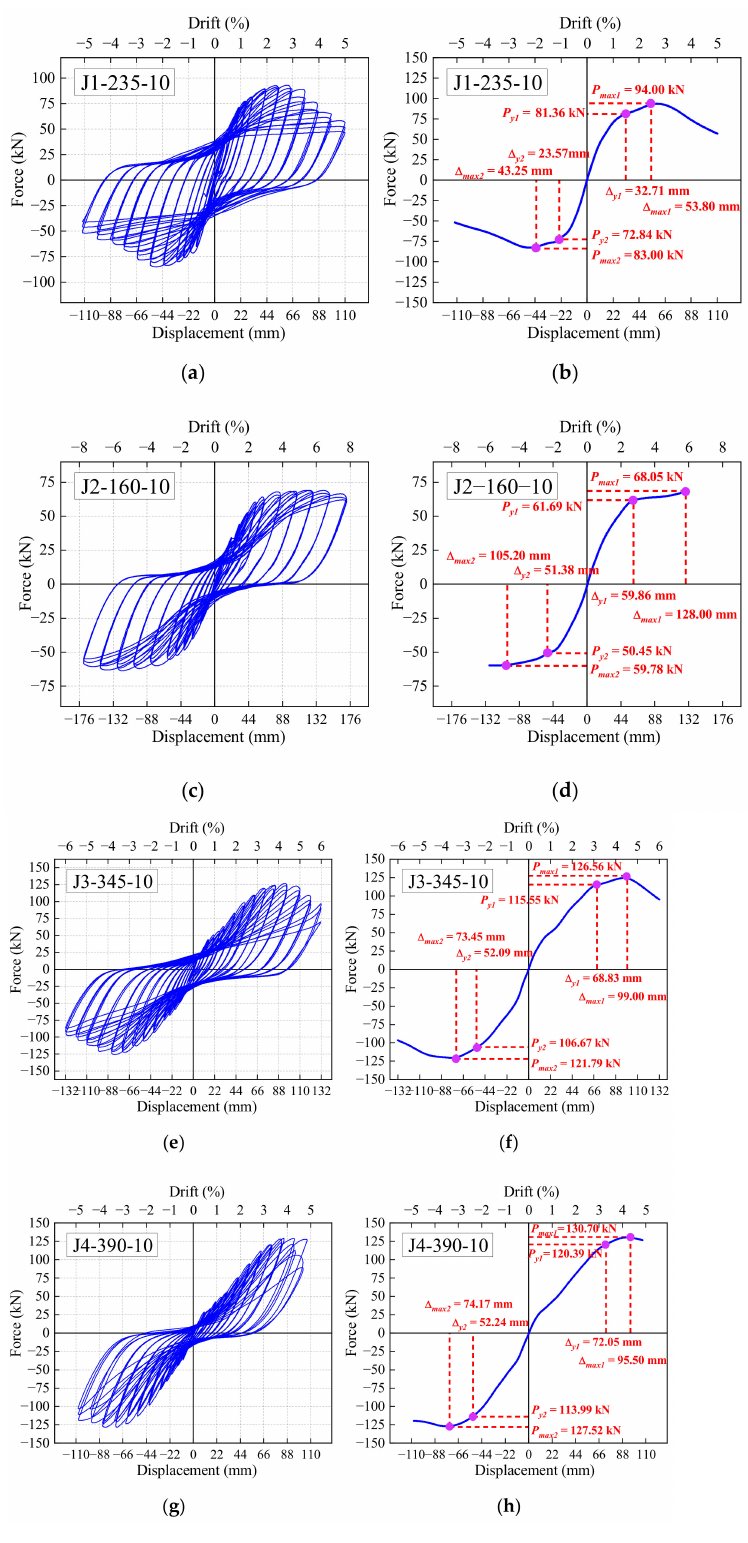
Figure 12. Hysteresis and skeleton curves: ( a ) Hysteresis curves of J1-235-10; ( b ) Skeleton curves of J1-235-10; ( c ) Hysteresis curves of J2-160-10; ( d ) Skeleton curves of J2-160-10; ( e ) Hysteresis curves of J3-345-10; ( f ) Skeleton curves of J3-345-10; ( g ) Hysteresis curves of J4-390-10; ( h ) Skeleton curves of